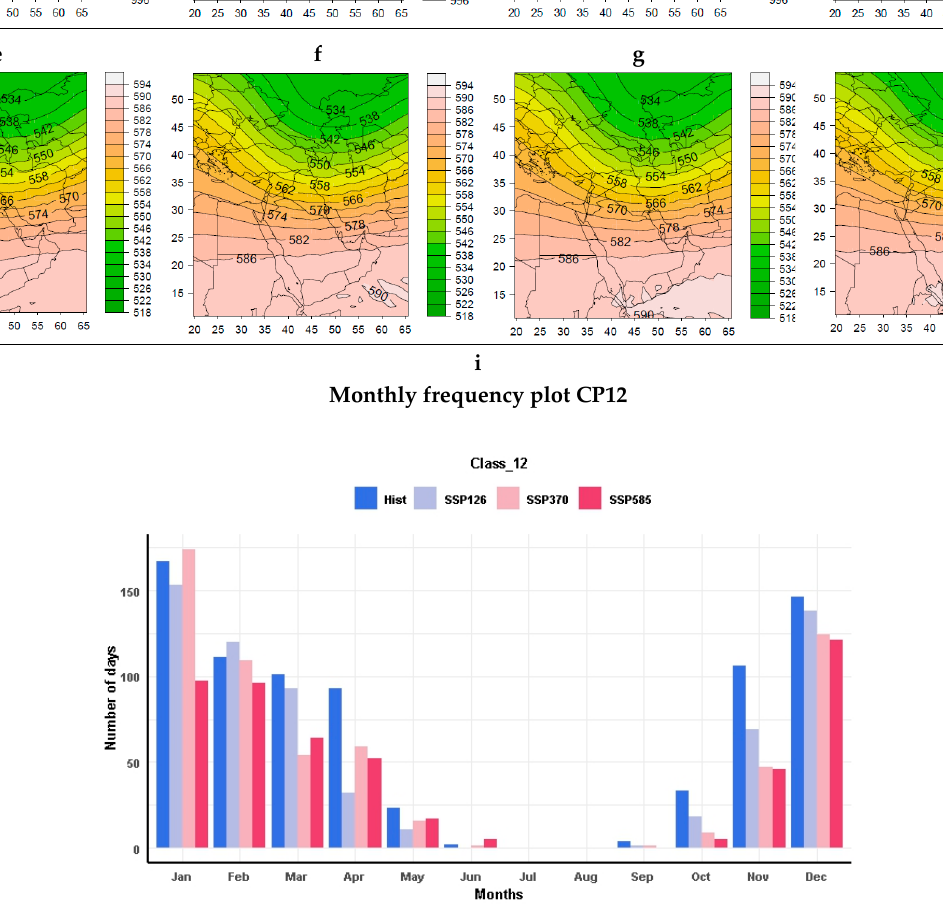
Figure 14. As in Figure 3 for CP12.